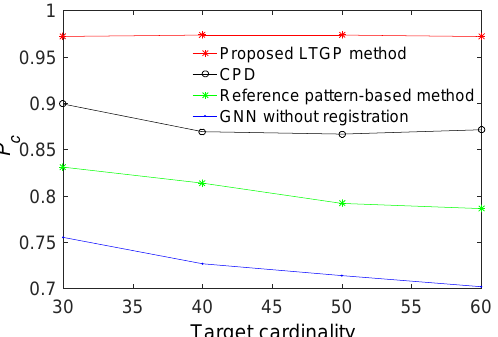
Figure 8. Correct association probabilities of GNN without registration, reference pattern-based algorithm, correlation-based algorithm and the proposed method for a detection probabilities of P d = 0.9 when target cardinality changes within a fixed surveillance